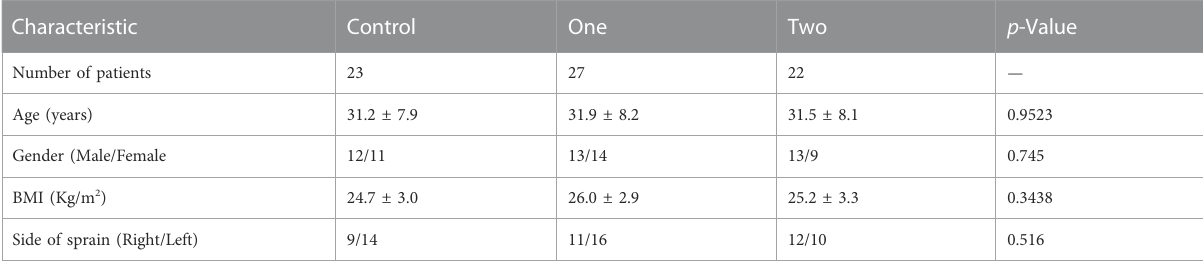
TABLE 1 Patient demographics characteristics a . Characteristic